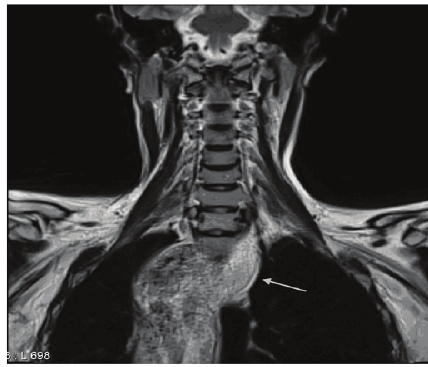
F 2: MRI scan of the neck region showing the extent of the esophageal dilatation (arrow) (coronal